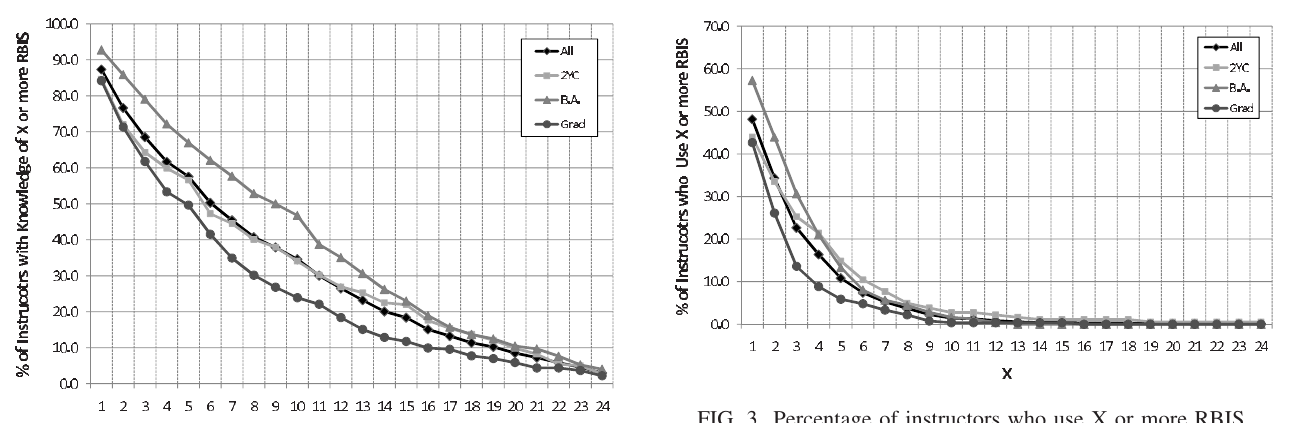
FIG. 3. Percentage of instructors who use X or